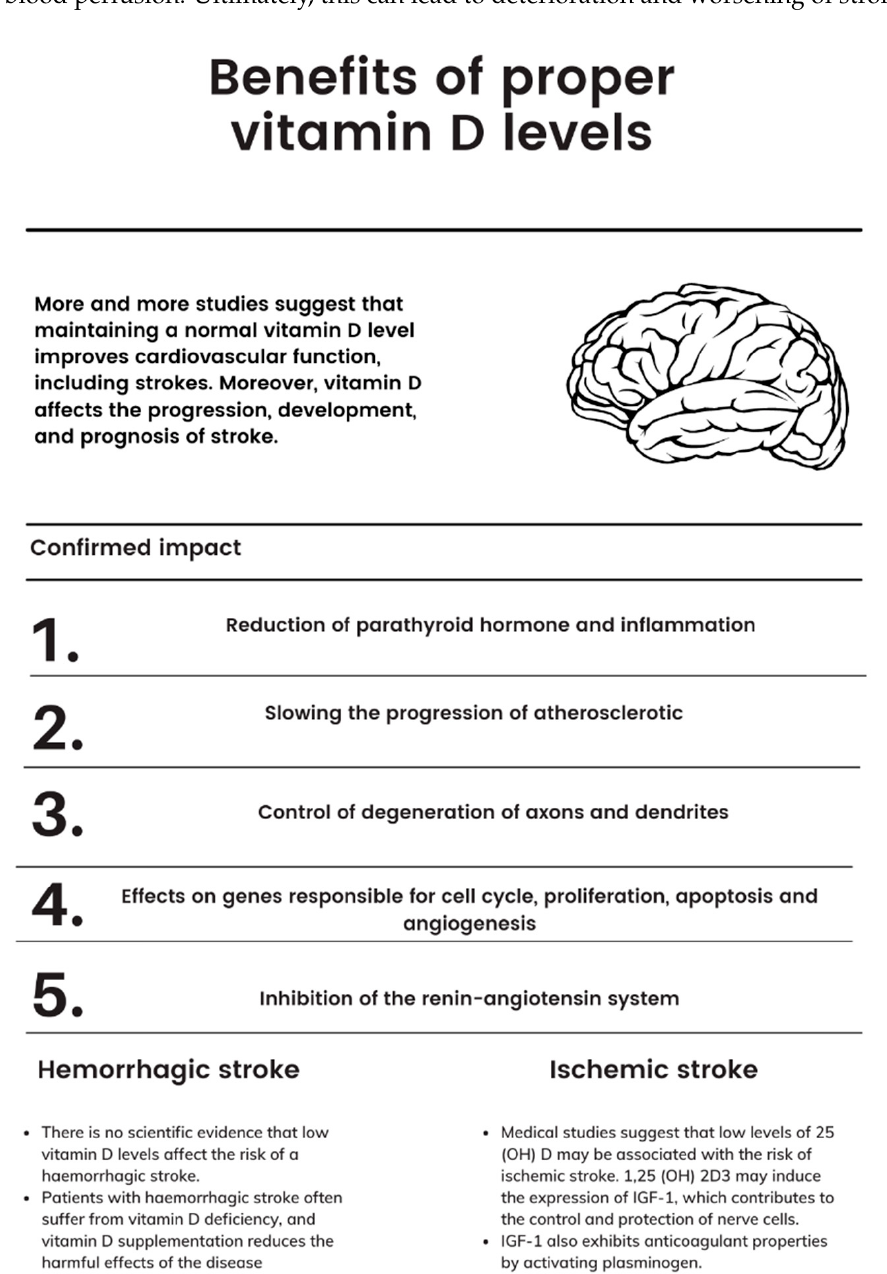
Figure 1. Benefits of proper vitamin D supplementation.